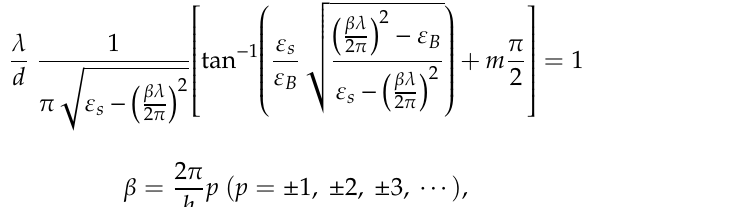
(cid:118)(cid:117)(cid:117)(cid:117)(cid:117)(cid:117)(cid:116)(cid:16)